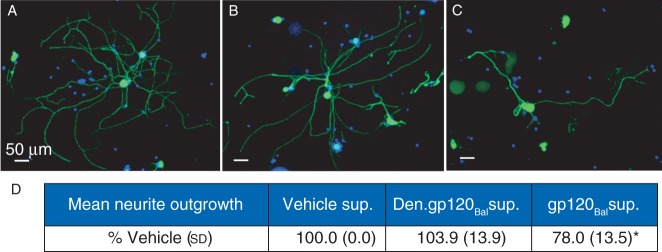
Neurite analysis after exposure to conditioned BMDM media. (a–c) Representative images of primary DRG cultures immunolabelled for βIII-tubulin (green) and nuclei counterstained with Hoechst 32258 (blue). One-day-old DRG cultures were treated for 24 h with DMEM/F-12 supplemented 1:1 with culture media from BMDMs stimulated for 4 h prior with (a) vehicle, (b) 2 nM denatured-gp120Bal, or (c) 2 nM gp120Bal. Scale bars=50 µm. DRG cultures treated with culture media from gp120Bal-treated BMDMs showed a significant reduction in the mean NOPN, as a percentage of vehicle-treated cultures (d). Conditioned media from denatured-gp120Bal-treated BMDMs induced no change in neurite outgrowth relative to vehicle control. Data presented as mean (sd). *P<0.05 vs vehicle-treated cultures, using one-way anova and Tukey's post hoc analysis (n=5–6; five to six technical replicates across two biological studies).